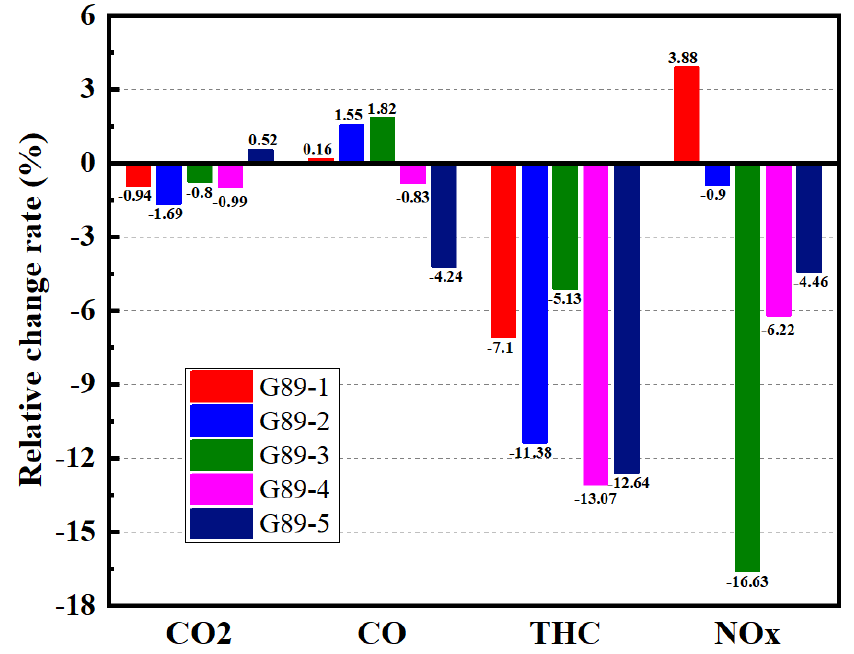
Figure 8. The relative change rate (%) of the five mixed fuels relative to the base fuel (G89) on the four gaseous emissions.